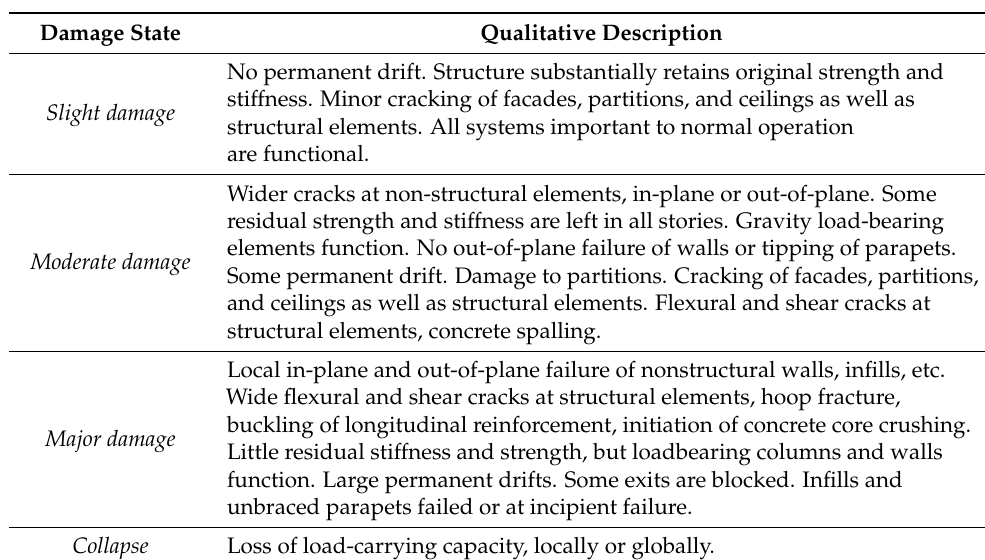
Table 1. Classification and description of seismic damage according to